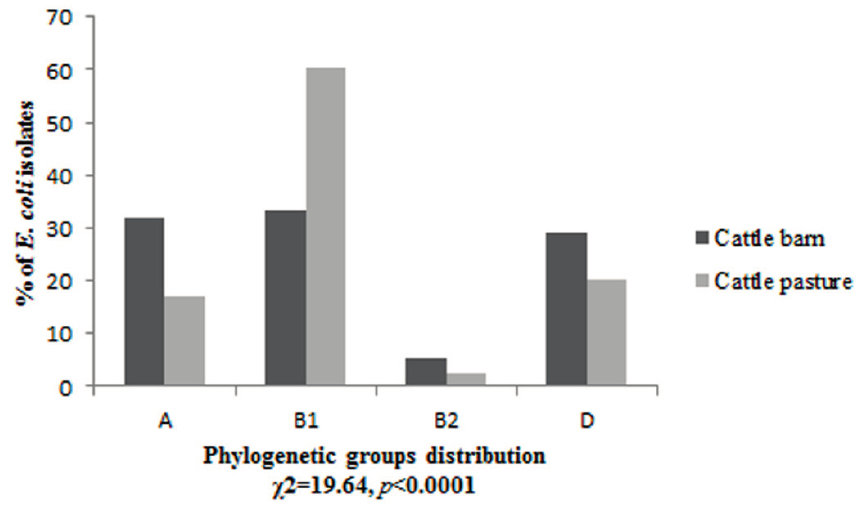
Figure 1. The phylogenetic structure of E. coli isolates derived from two groups of cattle housing in the barn and living in the